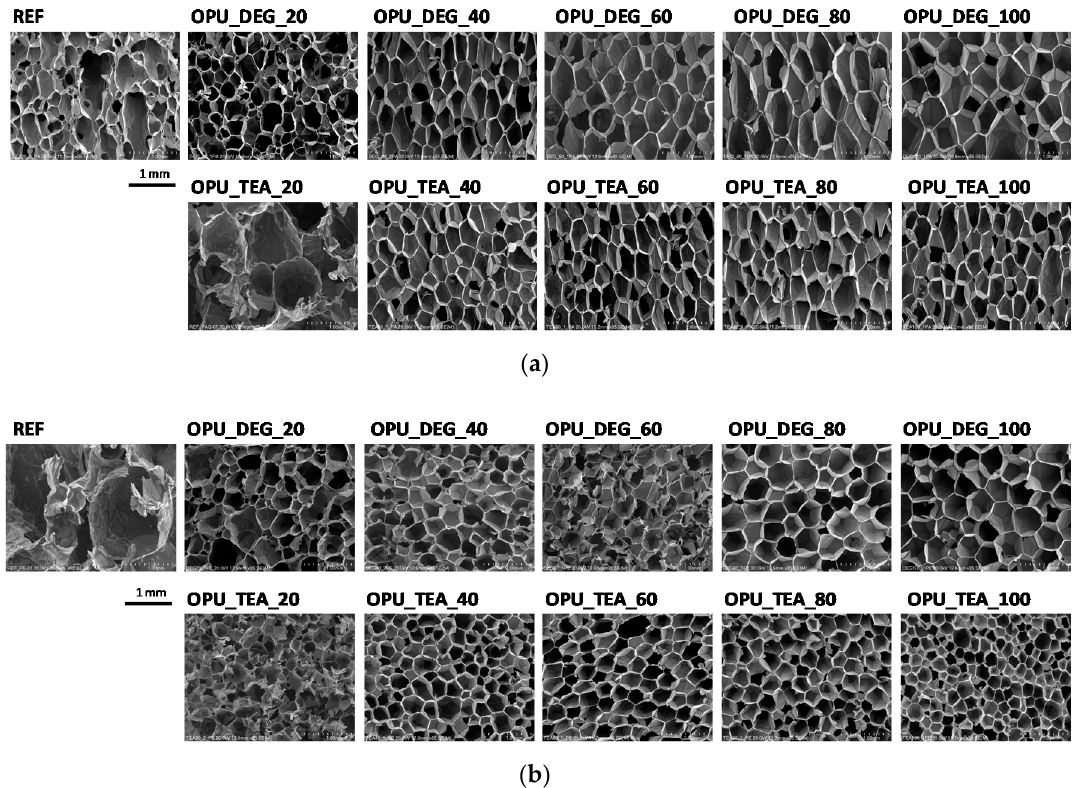
Figure 3. SEM images of foams cell structure in cross-sections: ( a ) parallel and ( b ) perpendicular with respect to direction of foam rise.